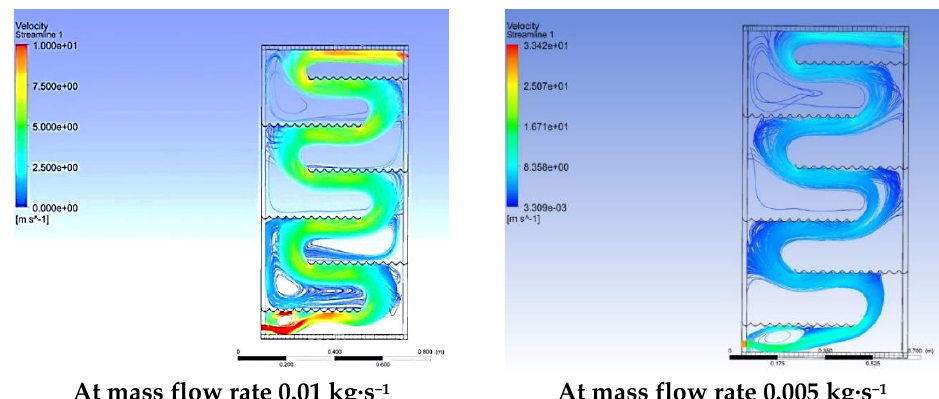
Figure 3. Performance prediction of an air-flow distribution pattern using CFD for the SAH. (e x = 10 x )